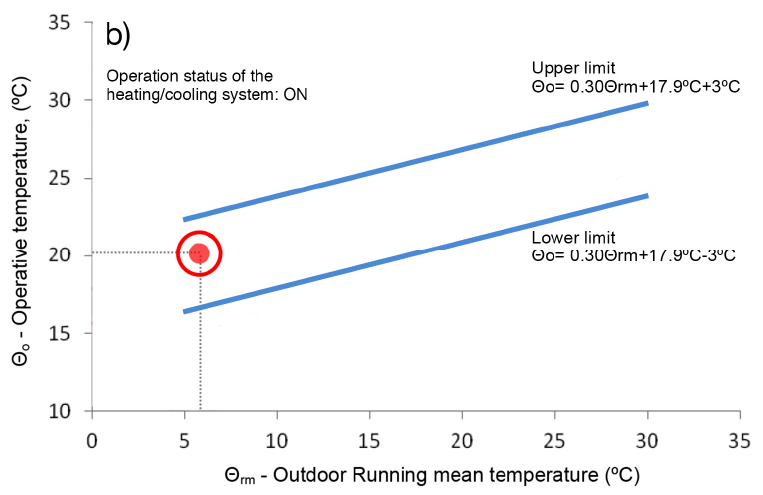
Figure 15. Thermal comfort temperature (operative temperature) in the living room during winter monitoring when the heating system was on, based in the relation between the limits of the indoor operative temperature ( Θ o ) as a function of the exponentially-weighted running mean of the outdoor temperature ( Θ rm ) (adapted from